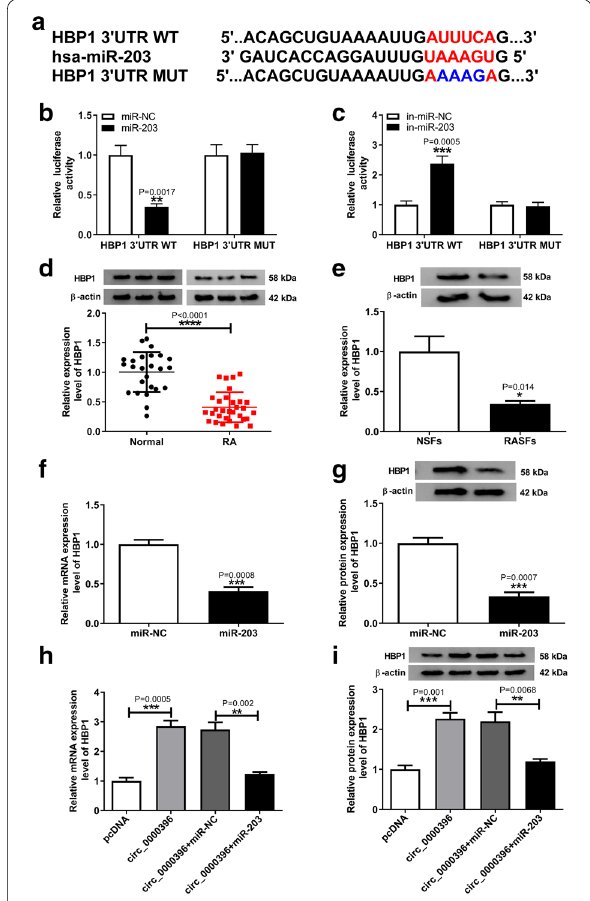
Fig. 5 Circ_0000396 can directly regulate miR-203 targeted gene HBP1 in RASFs. a The putative binding sits between HBP1 3΄UTR and miR-203 were listed. b , c The interaction between circ_0000396 and miR-203 was confirmed by the dual-luciferase reporter assay in RASFs (Mann–Whitney U-test). d , e The protein expression of HBP1 in RA synovial tissues and healthy control tissues, as well as in RASFs and NSFs was detected by western blot (Student’s t test). f , g qRT-PCR or western blot analysis of HBP1 expression in RASFs transfected with miR-NC, or miR-203 was conducted (Student’s t test). h , i Levels of HBP1 in RASFs transfected pcDNA, circ_0000396, circ_0000396 miR-NC, circ_0000396 miR-203 were detected by + + qRT-PCR or western blot (ANOVA). * p < 0.05, ** p < 0.01, *** p <